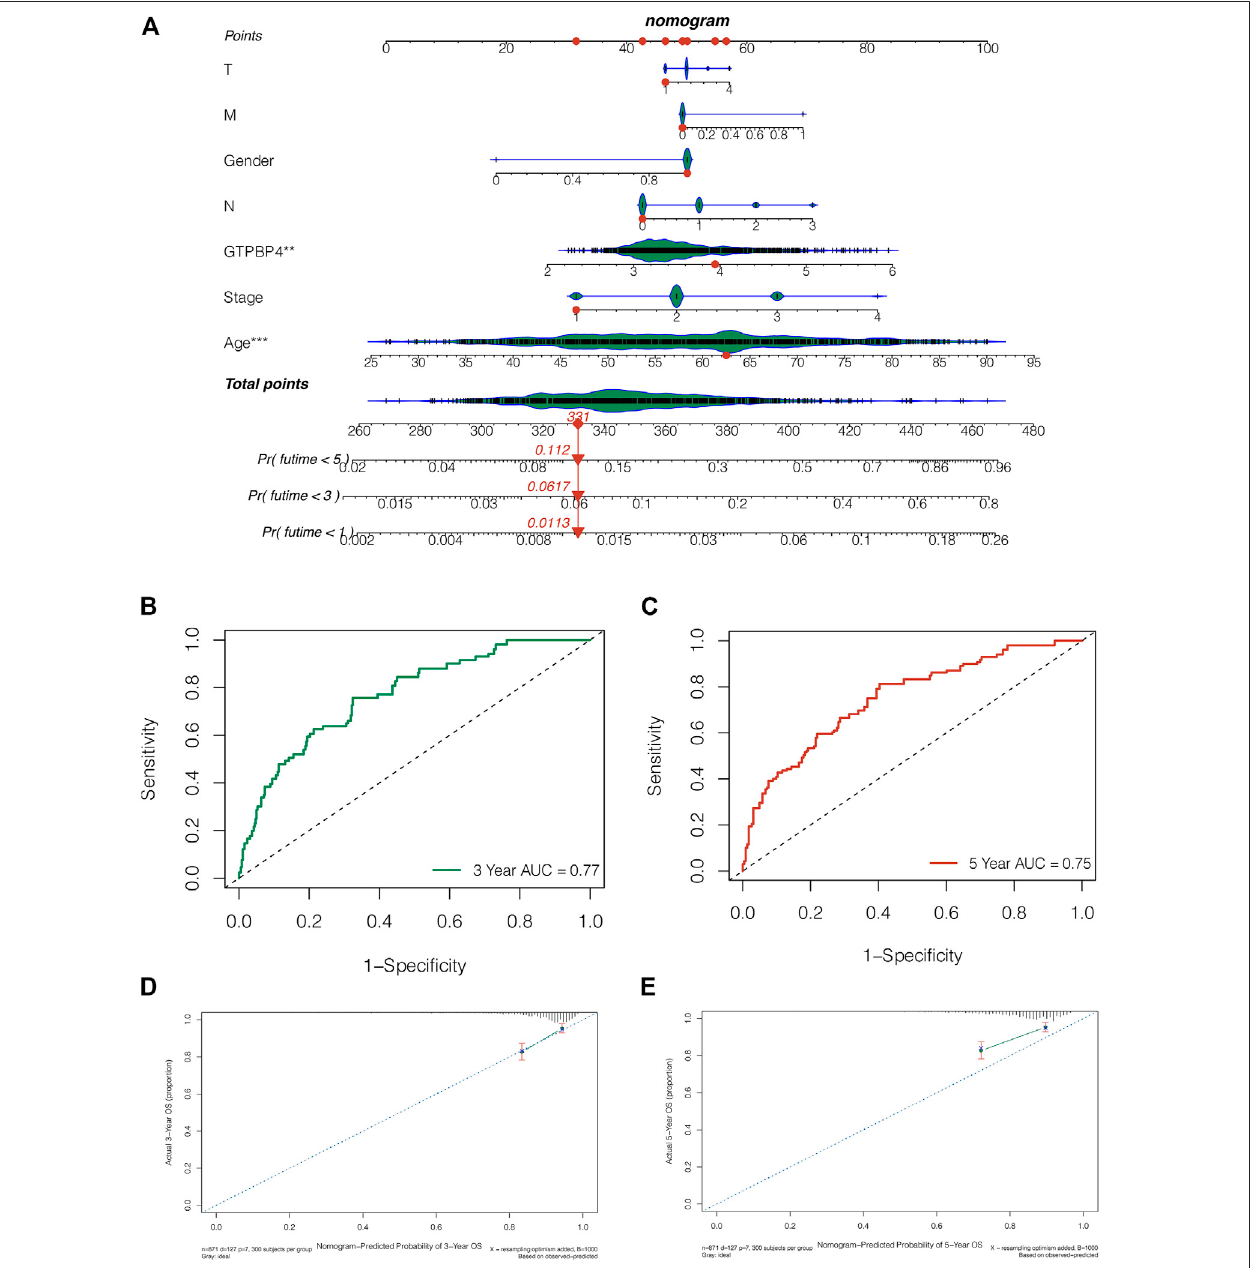
FIGURE 8 | Nomogram was constructed to predict the prognosis of breast cancer patients. (A) The nomogram combining the expression of GTPBP4 and clinical characteristics. The 1-, 3-, and 5-years mortality rates of patient “ TCGA-AR-A255 ” were 0.0113, 0.0617 and 0.112, respectively (B,C) The AUC values of this nomogram ’ s 3-years and 5-years ROC curves are 0.77 and 0.75, respectively (D,E) The 3-years and 5-years calibration curves showed that the nomogram can accurately predict the survival of breast cancer patients.